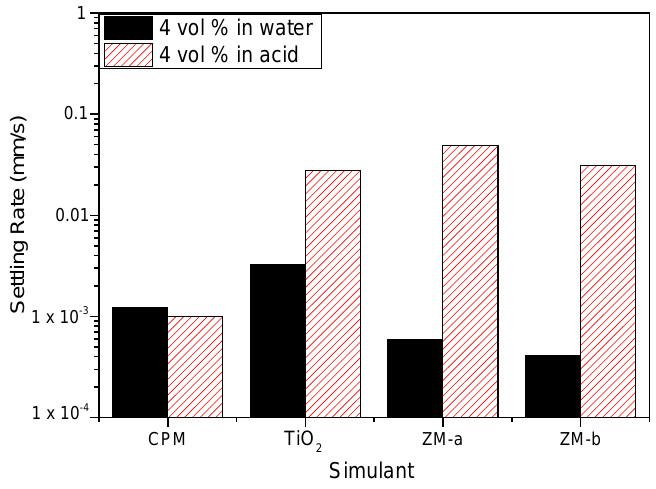
Figure 9. Settling rates for caesium phosphomolybdate (CPM), titanium dioxide (TiO 2 ) and zirconium molybdate (ZM-a and ZM-b) at 4 vol% concentration in both water and 2 M HNO 3 environments.